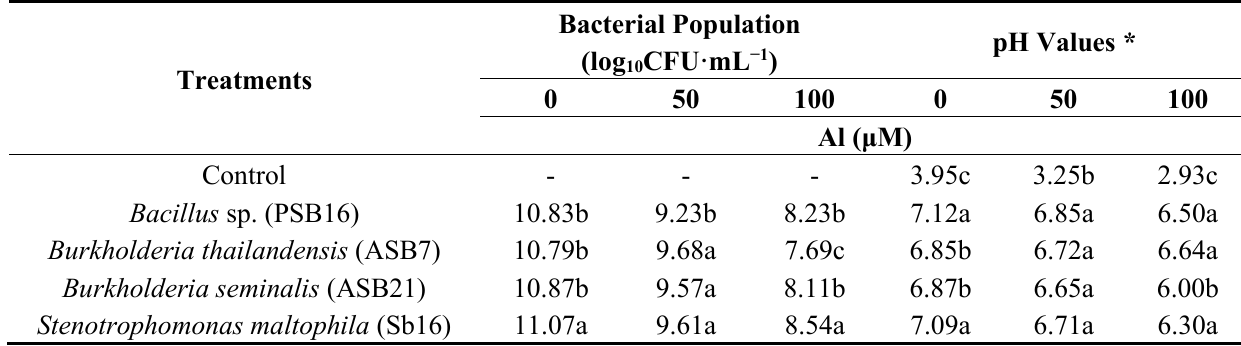
Bacterial Population pH Values * (log CFU·mL −1 ) 10 0 50 100 0 50 100 Al (μM)